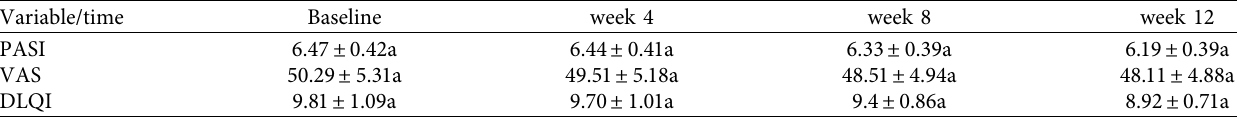
The difference letters in each row show significant difference at p < 0 . 05.